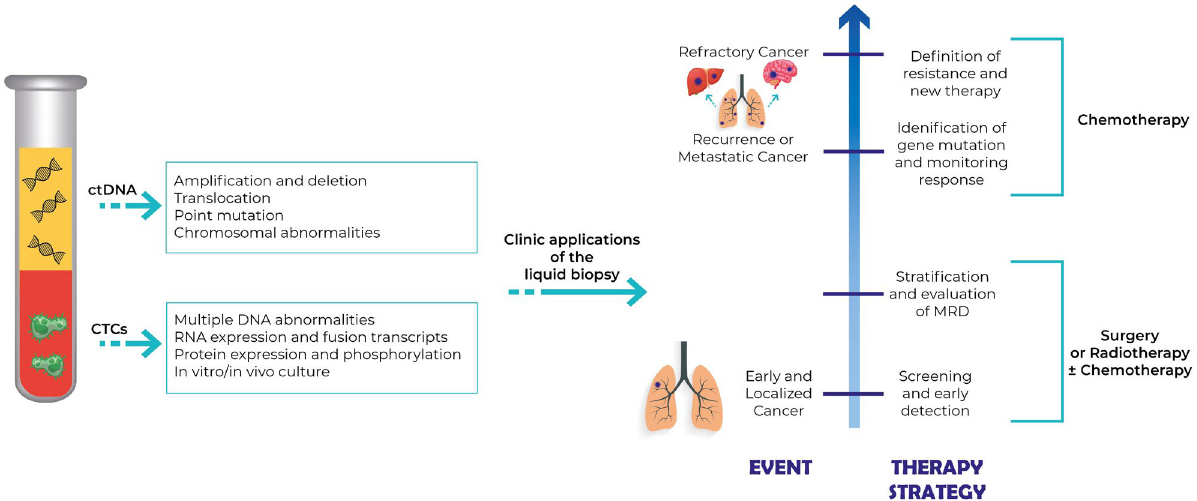
Figure 1. Clinical application of liquid biopsy in